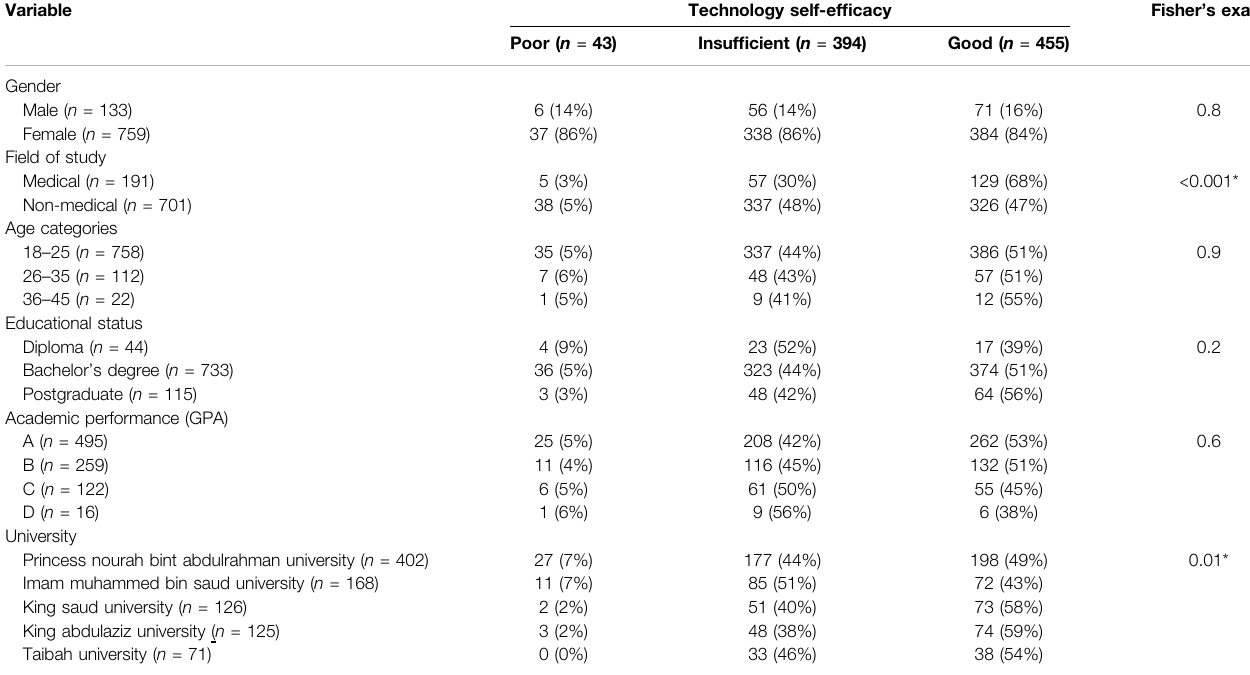
TABLE 3 | Level of self-ef fi cacy in the technology domain by student